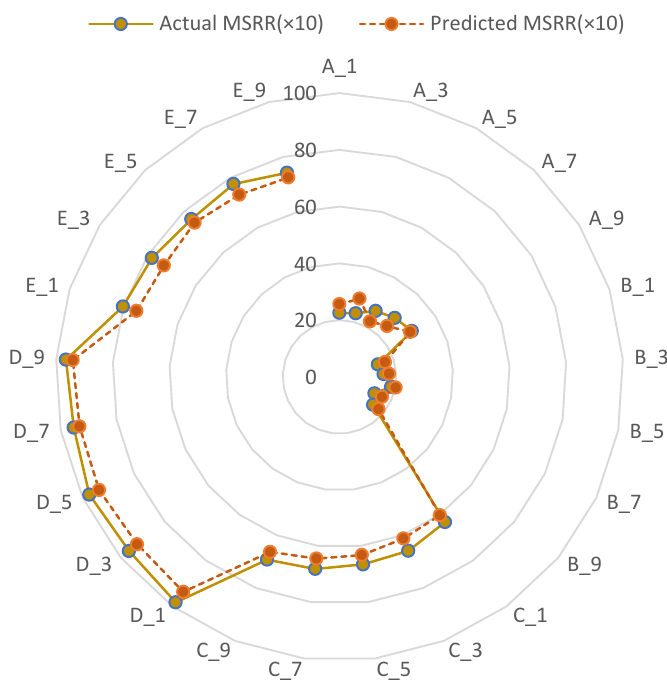
Figure 12. Demonstration of the actual and predicted MSRR values of chernozem soils on tests A_1 to E_10, implemented on layers A – E, respectively.